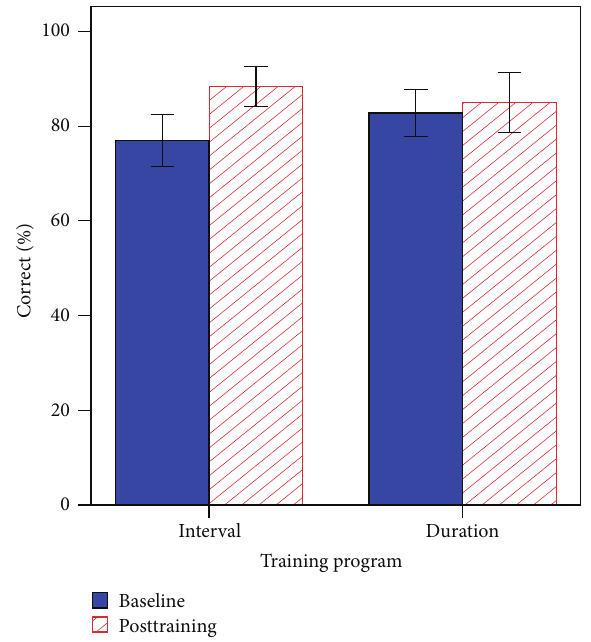
Figure 6: Baseline and posttraining performance for consonant discrimination in quiet. Error bars indicate 1 standard